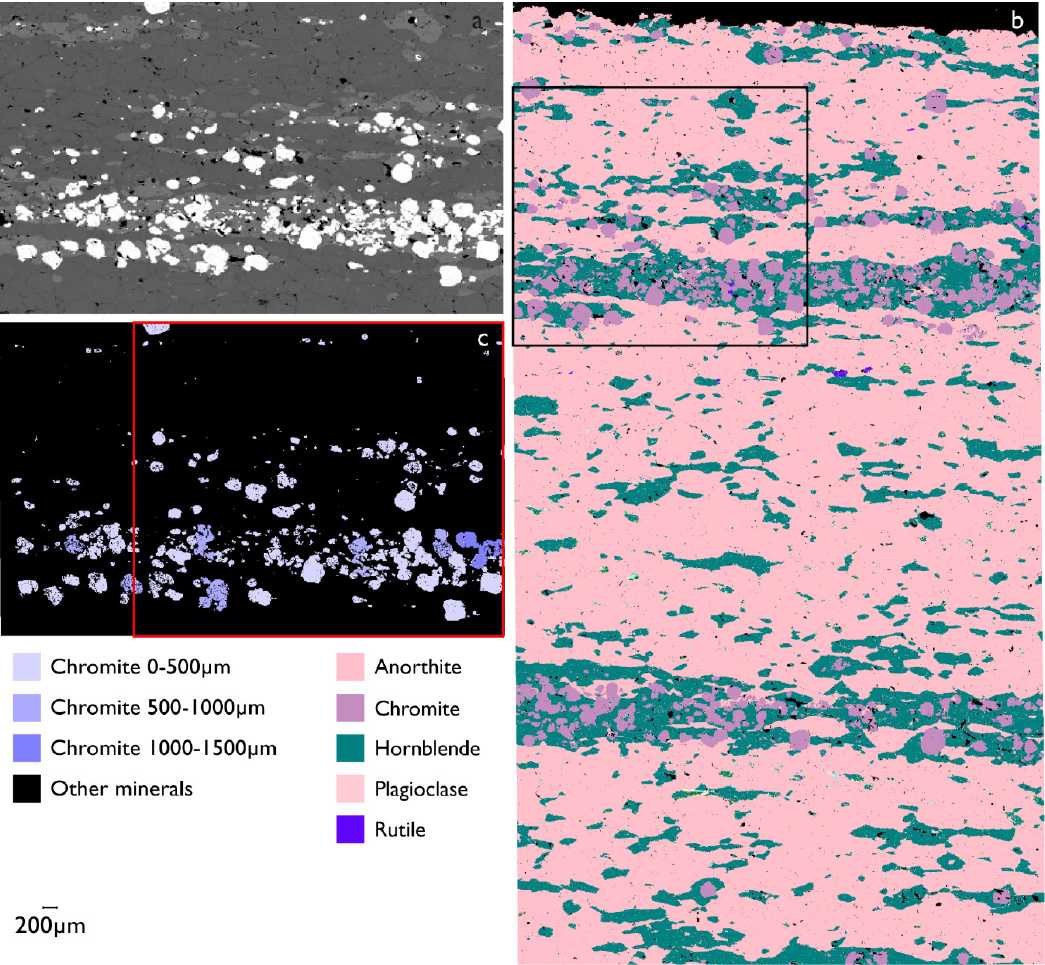
Figure 11. Leucogabbro with bands of chromite, sample 510152. ( a ) BSE micrograph of part of sample, showing chromite grains in white. ( b ) Mineral map of a larger part of the same sample. Chromite is associated with hornblende. 1.63 million pixels. ( c ) Grain size map showing the same part of sample as in (a), with colour-coding of the chromite grain sizes. (a) and (c) partially overlap with the upper left part of (b), indicated with squares in (b) and (c).